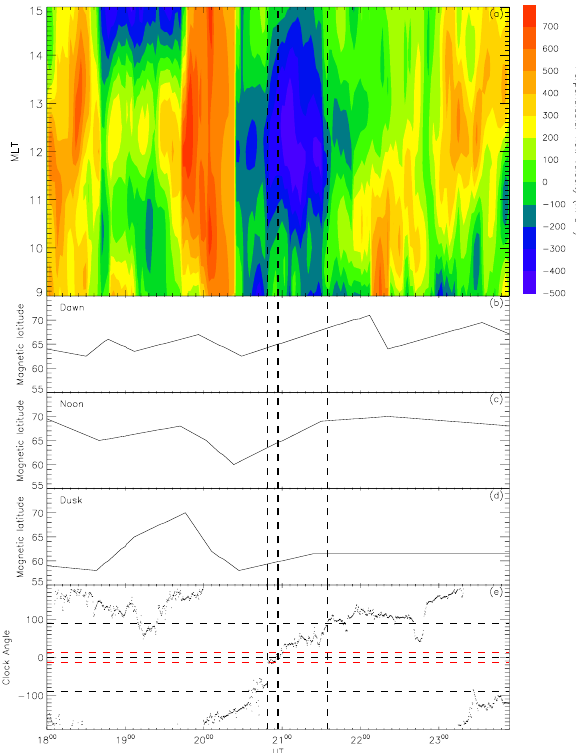
Fig. 7. (a) A contour plot showing the velocity of plasma flow across the OCB, determined from the keograms in Fig. 4. Blue represents flow equatorward while red represents flow poleward. (b) , (c) , (d) show the latitude of the OCB at 06:00, 12:00 and 18:00 MLT. (e) is the clock angle measured at the ACE space- craft lagged to the magnetopause. One interval of equatorward flow across the OCB can be clearly identified beginning at 20:49 UT. The first vertical dashed line marks the time at which the clock an- gle passed through − 15 ◦ , the angle at which it has been calculated that DLR would be expected to commence. The second vertical line represents the time at which the clock angle passes through zero. The third vertical line marks the time at which the IMF turns southwards and coincides with the end of the sunward